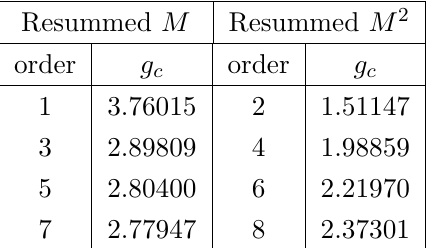
Figure 5 . Order by order predictions for the critical coupling. The dots correspond to values ob- tained by resumming M at odd orders while the crosses represent the values obtained by resumming M 2 at even orders. The straight line represents the prediction g c = 2 . 807(34) obtained in ref. [19] by resumming M to N 8 LO .